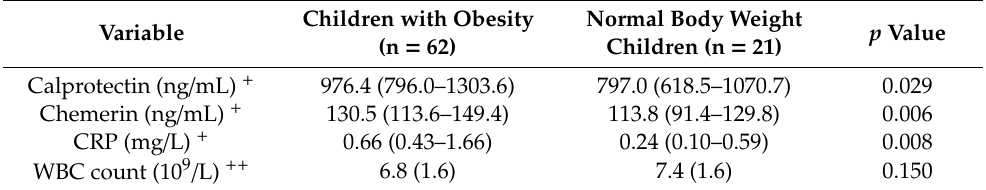
Table 1. Biochemical parameters in children with obesity and normal body weight.